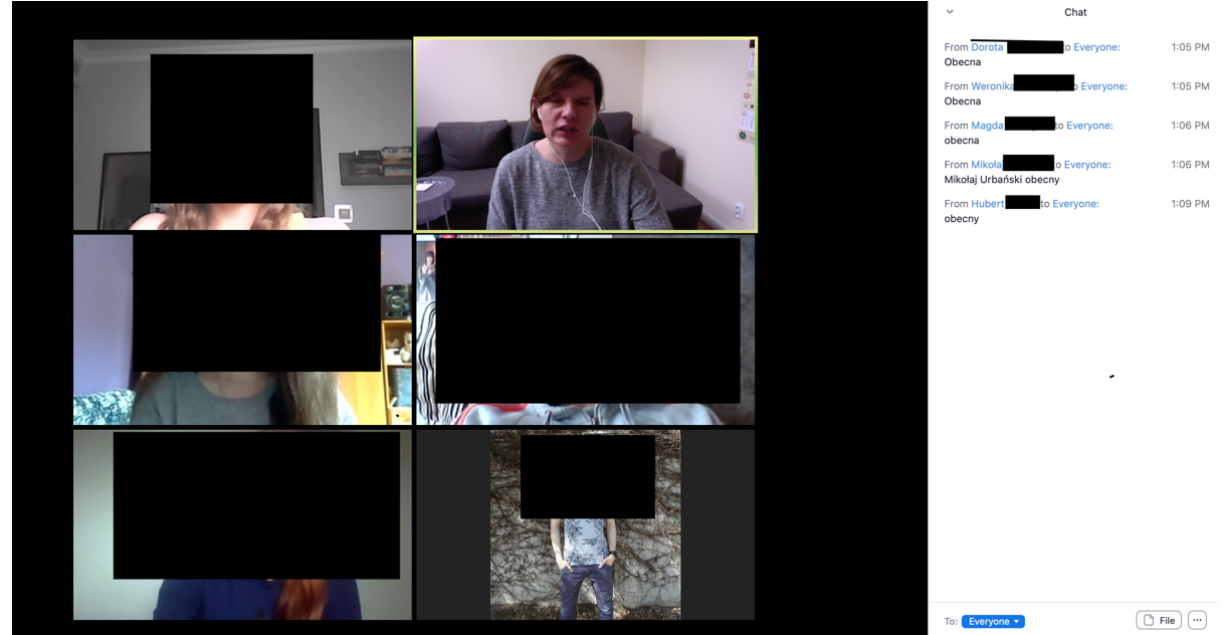
Figure 1. An anonymized screen shot from an individual Zoom